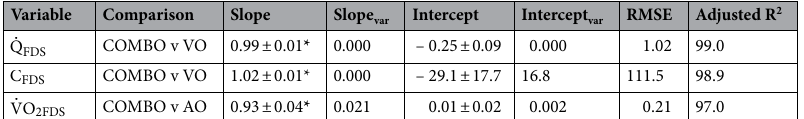
Table 3. Linear mixed effects model of the relationship between muscle blood flow via the venous (VO) and combined occlusion (COMBO) methods, and of the relationship between muscle O 2 uptake obtained via the arterial (AO) and COMBO methods. Values represent means ± SEM. FDS: flexor digitorum superficialis ˙ Q and C: muscle blood flow and vascular conductance, respectively; muscle; variance; RMSE: root mean squared error of the residual scores; R 2 : coefficient of determination. *Significant parameter estimate, P <